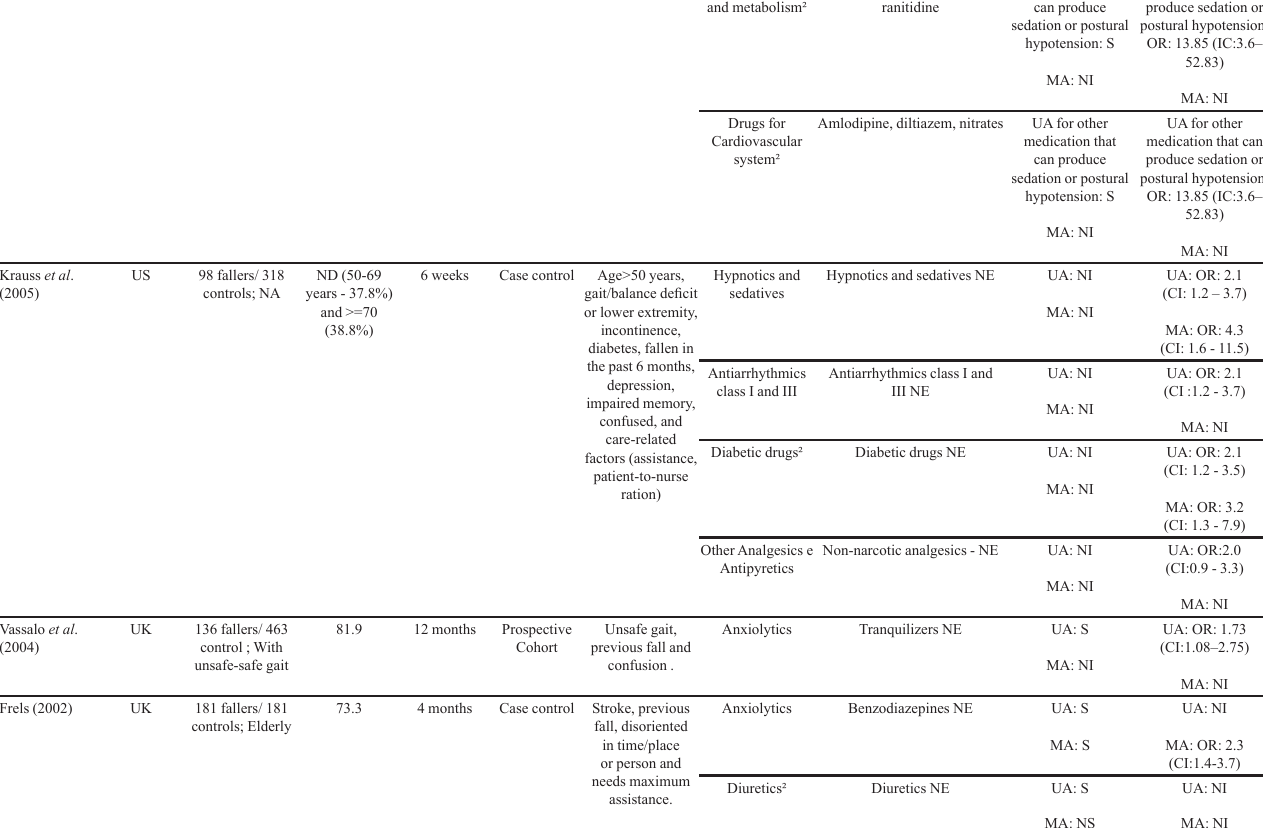
Cardiovascular system²